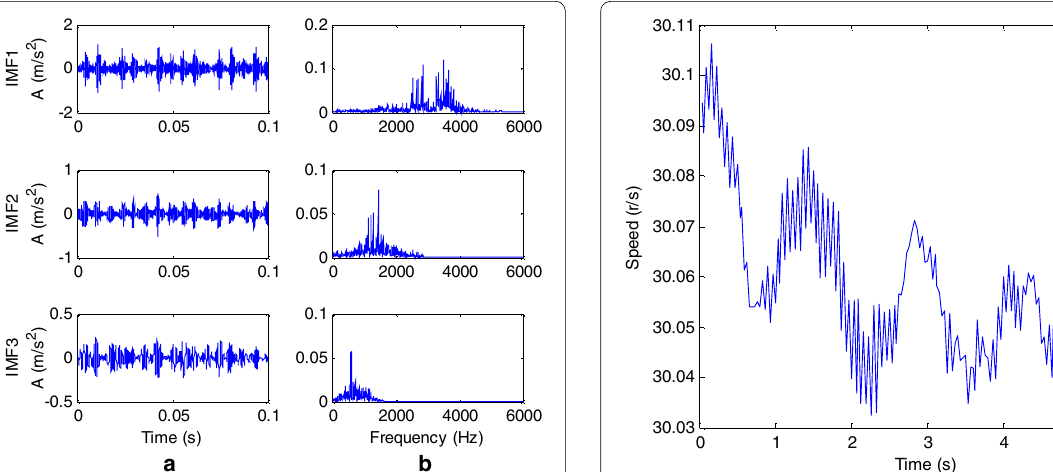
Figure 12 Speed changing along the time